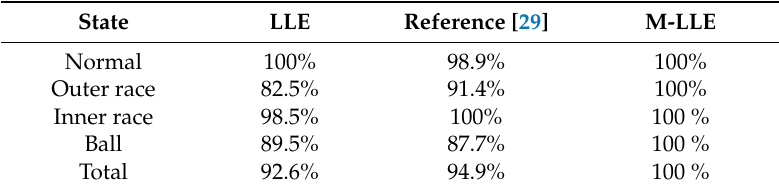
Table 4. The comparison experimental results in fault